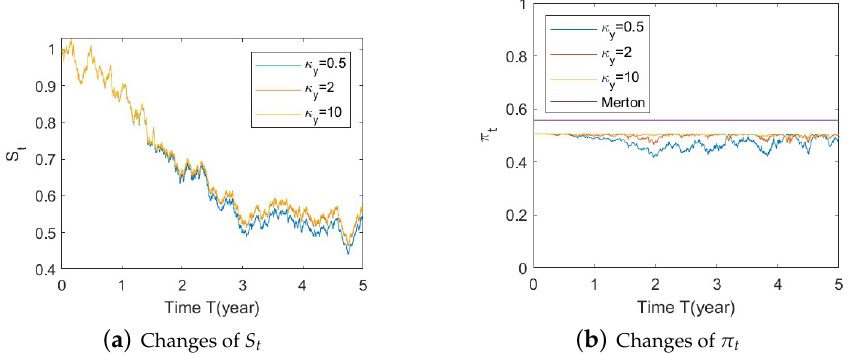
Figure A22. Illustrate the impact on ( a ) stock prices and ( b ) optimal stock allocations when varying the speed of reversion, κ y ( e . g ., κ y = 0.5,2,10 ) .